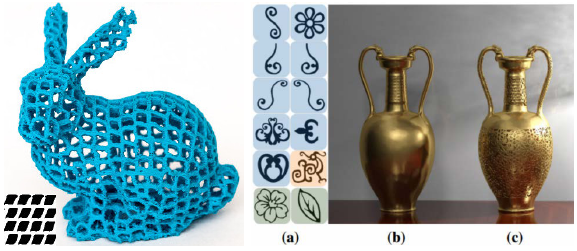
Synthesis for 3D fabrication. Left: results from Mart´ınez et al. [87]. Right: filigree from Chen et al. [88]. Subtle patterns of material and empty space are created along the surface of the object to resemble 2D exemplars. Reproduced with permission from Ref. [87], c (cid:13) Association for Computing Machinery, Inc. 2015, and Ref. [88], c (cid:13) Association for Computing Machinery, Inc.